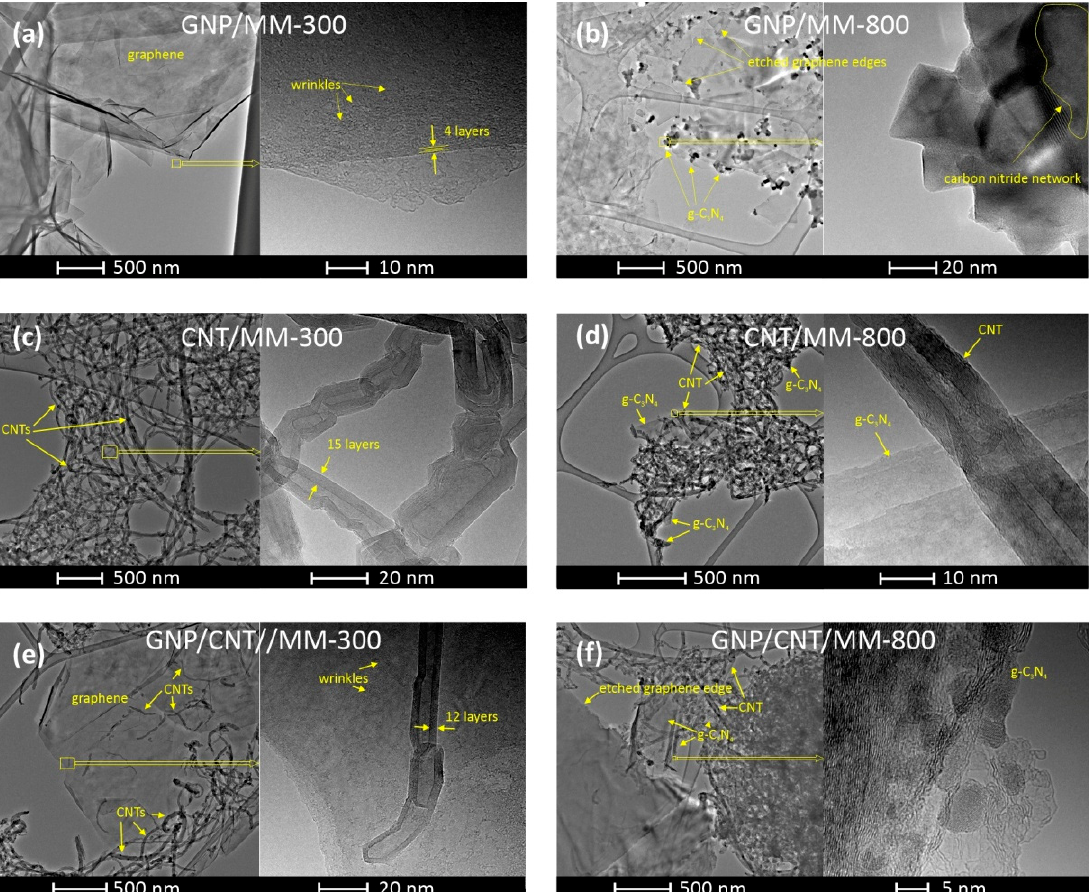
Figure 4. TEM images of GNP/MM ( a – b ), CNT/MM ( c – d ), and GNP/CNT/MM ( e – f ) composites carbonized at 300 °C and 800 °C.